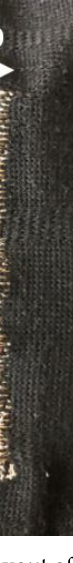
Figure 1. Layout of the embroidered sensor (dimensions in